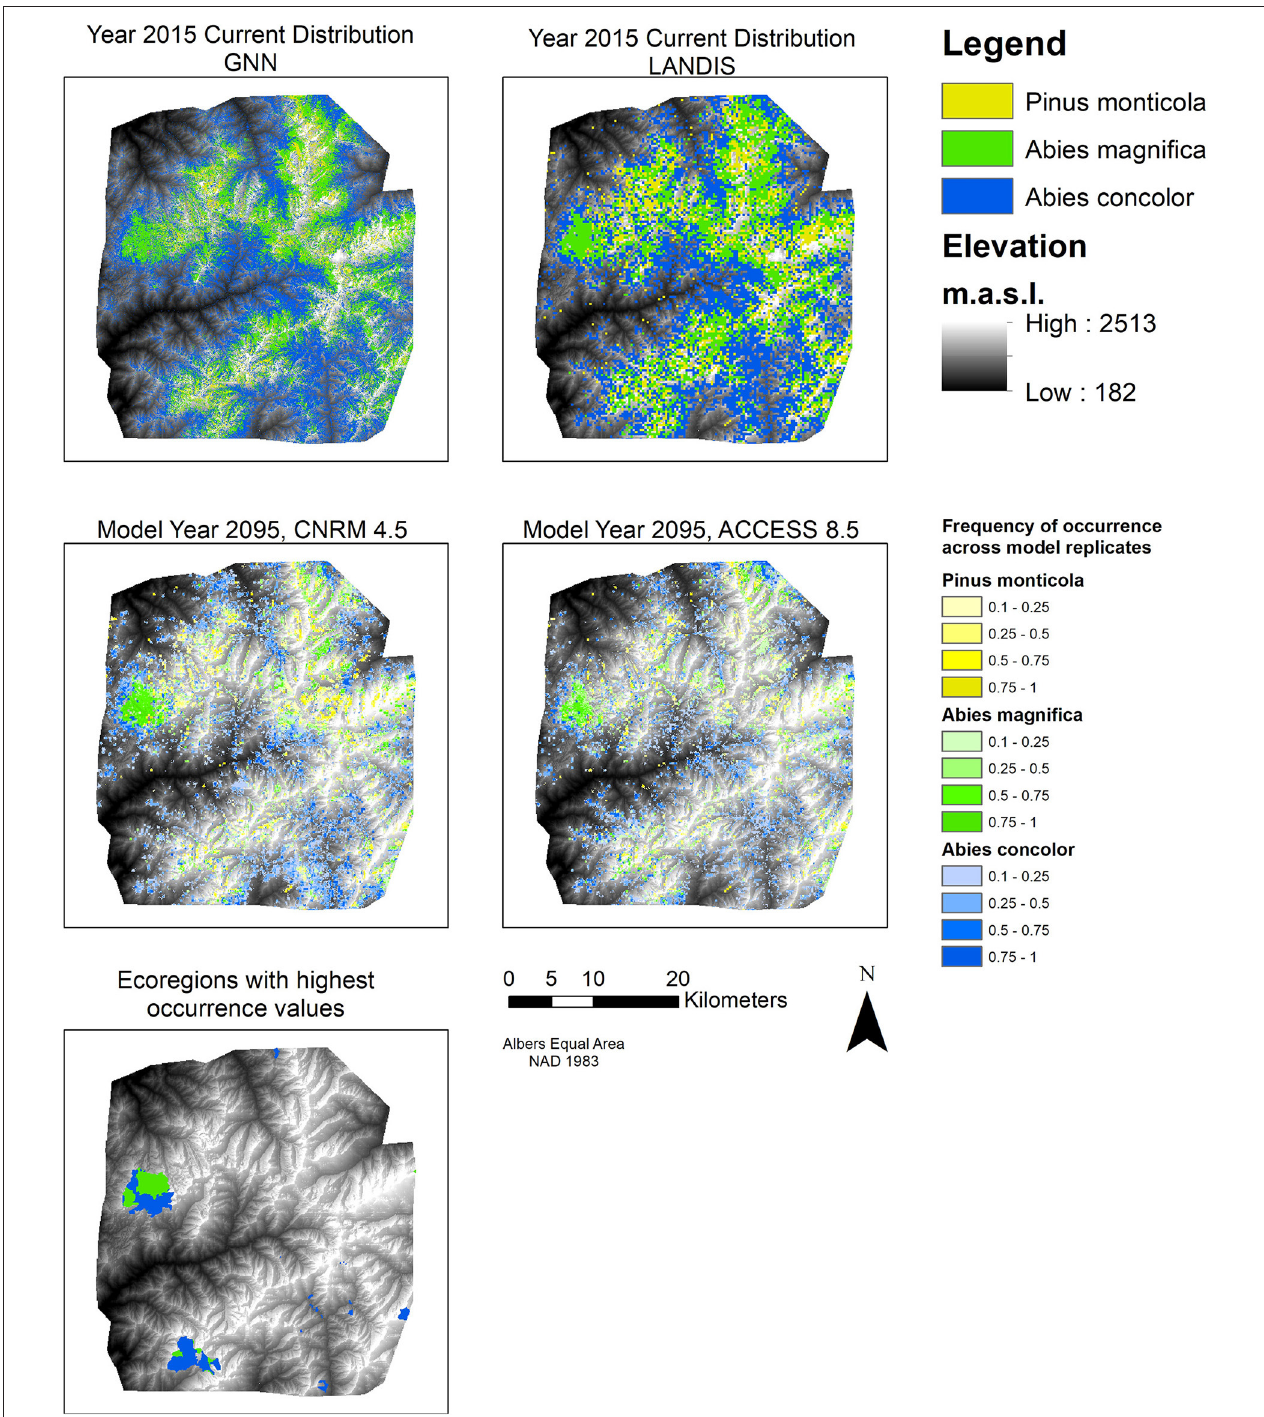
FIGURE 2 | Current and future projected distributions of three species. Top left shows the current distribution of these species from the GNN dataset. Top right shows initial distribution in LANDIS. Middle left map shows distributions in 2095 under CNRM rcp 4.5 (a warmer and wetter projection). Middle right map shows distributions in 2095 under ACCESS rcp 8.5 (a hotter and drier projection). The middle maps are composites of the seven model replicates: they represent an average of how often a particular cell was occupied by that species. A value of one indicates that that species was present in that cell across all seven replicates. A value of > 0.5 indicates that that species was present in more than half of the replicates. Bottom left map shows the climate ecoregions that were the most favorable for each species through the entire simulation duration.